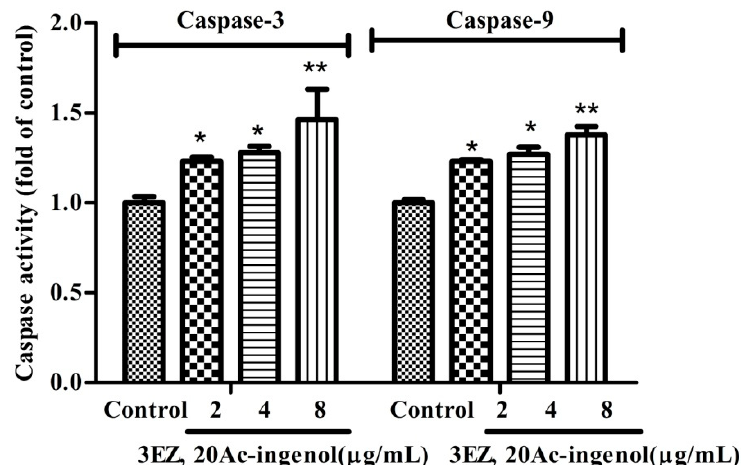
Figure 8. The effects of 3EZ, 20Ac-ingenol on caspases activation. L-O2 cells were treated with 3EZ, 20Ac-ingenol at the concentration of 2, 4, 8 µ g/mL for 48 h, respectively. The caspases activation was assayed by ELISA assay. Values are expressed as mean ± SD from three independent experiments, * P < 0.05, ** P < 0.01 compared with control group.